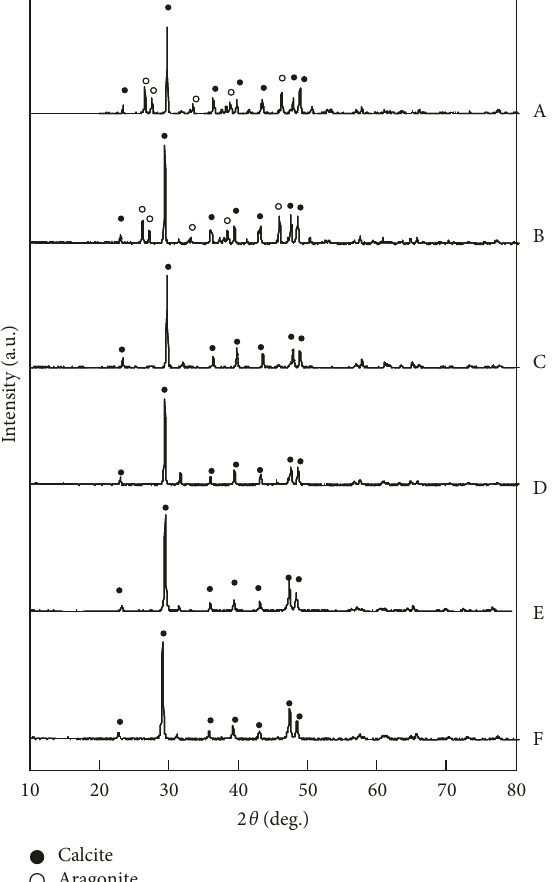
Figure 4: XRD patterns before and after hydrothermal hot pressing treatment: (A) CaCO and (B) molded solid obtained by HHP; (C) CaCO 3 -chitosan composite prepared at 4 ° C before HHP and (D) molded solid obtained by HHP; and (E) milled scallop shells before HHP and (F) molded solid obtained by